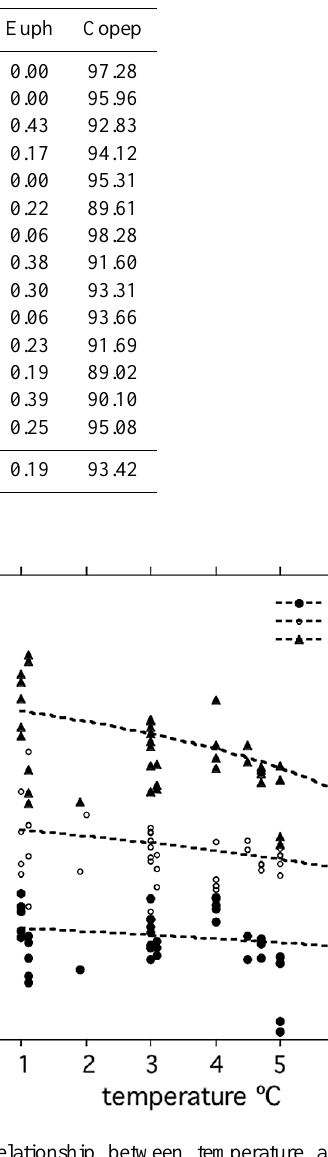
Table 3. Average temperature (Temp, ◦ C) and taxonomic composition (%) of zooplankton in the incubation experiments at the different stations. Amphi: Amphipods; Append: Appendicularians; Chaet: Chaetognaths; Cnid: Cnidarians. Euph: Euphausiaceans; Copep: Copepods. AVG: Average contribution of each taxon.